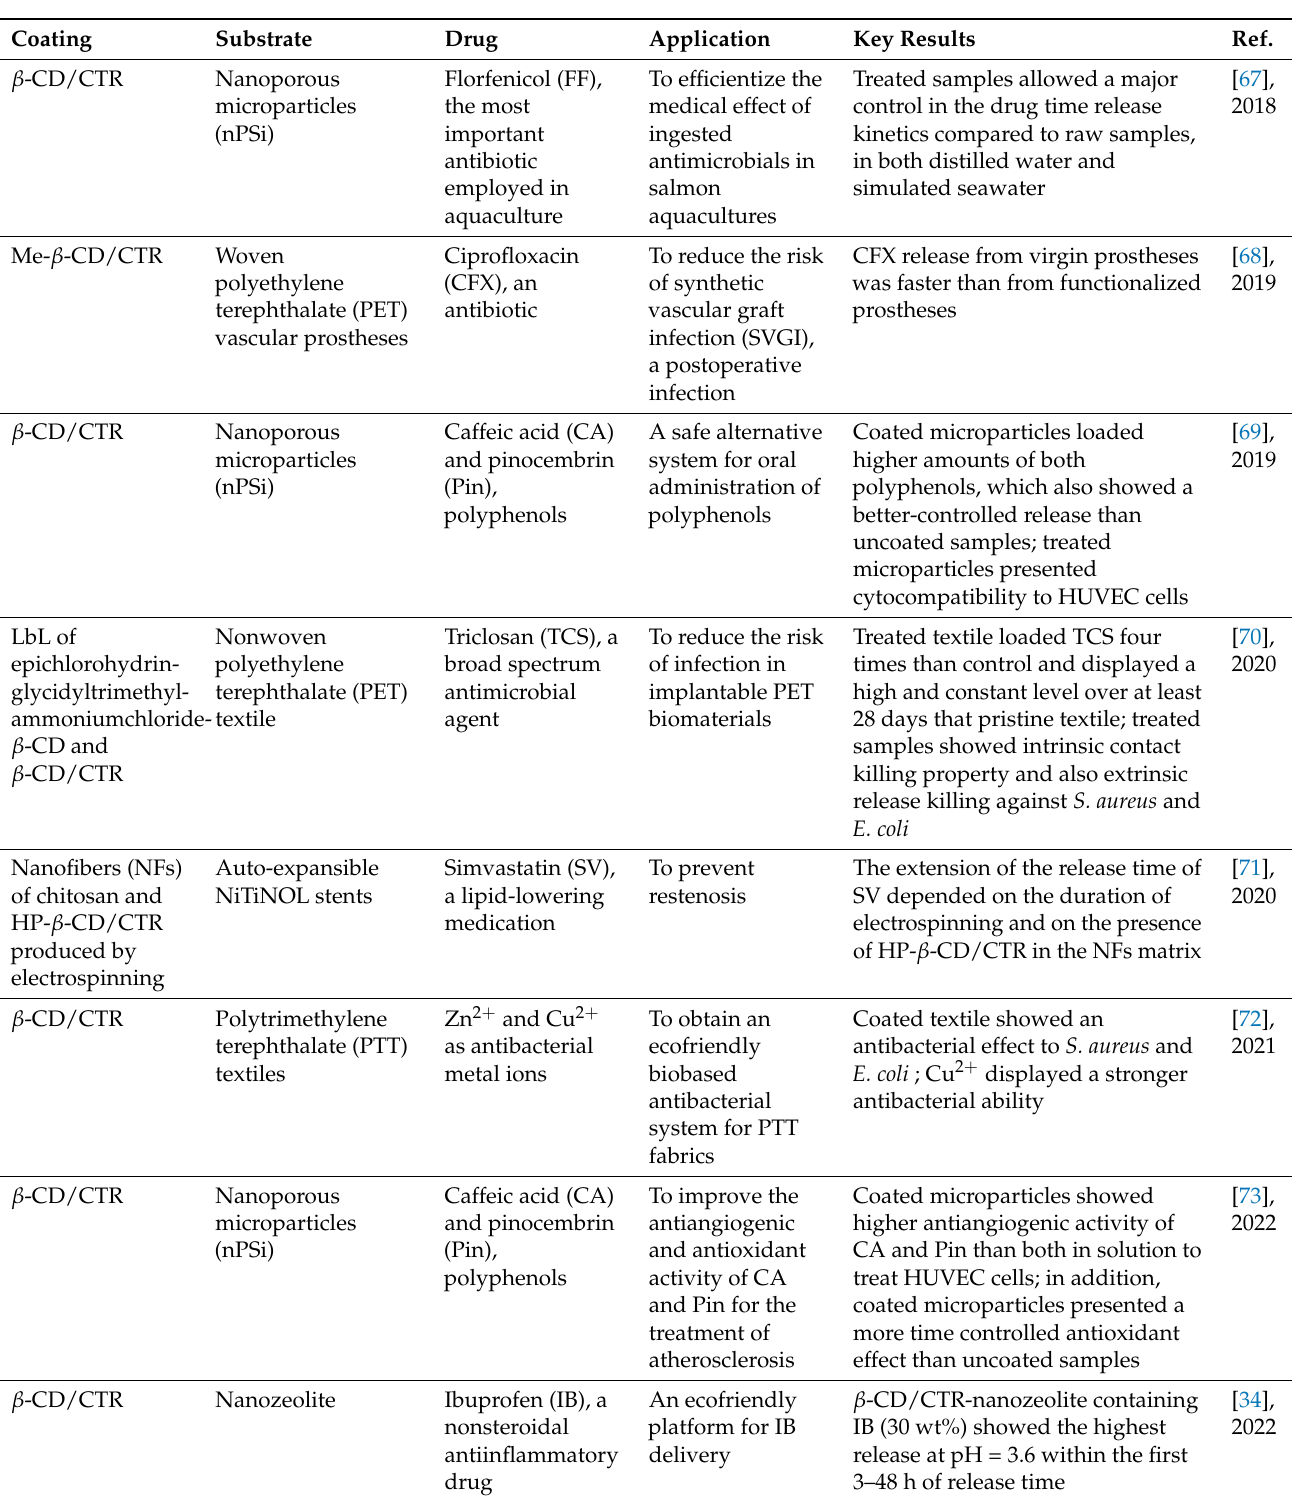
Table 5. Applications of coatings of cyclodextrin/citric-acid biopolymers as drug-delivery systems (Part